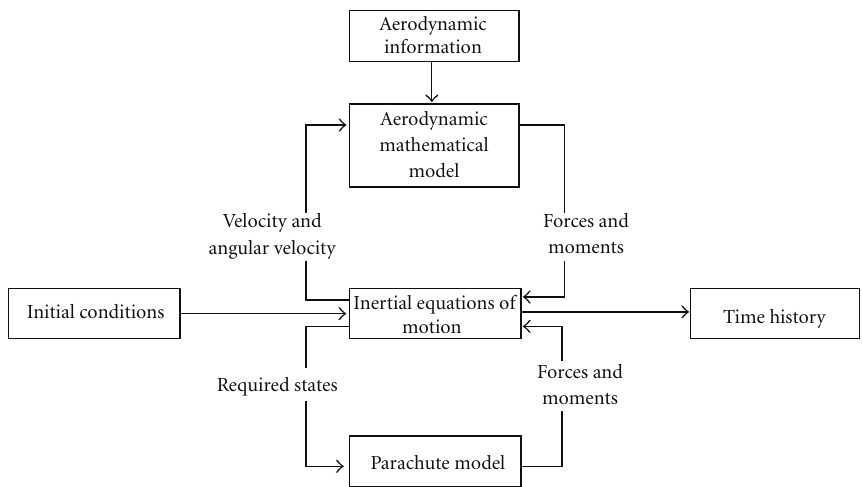
Figure 1: Flow chart of the simulation